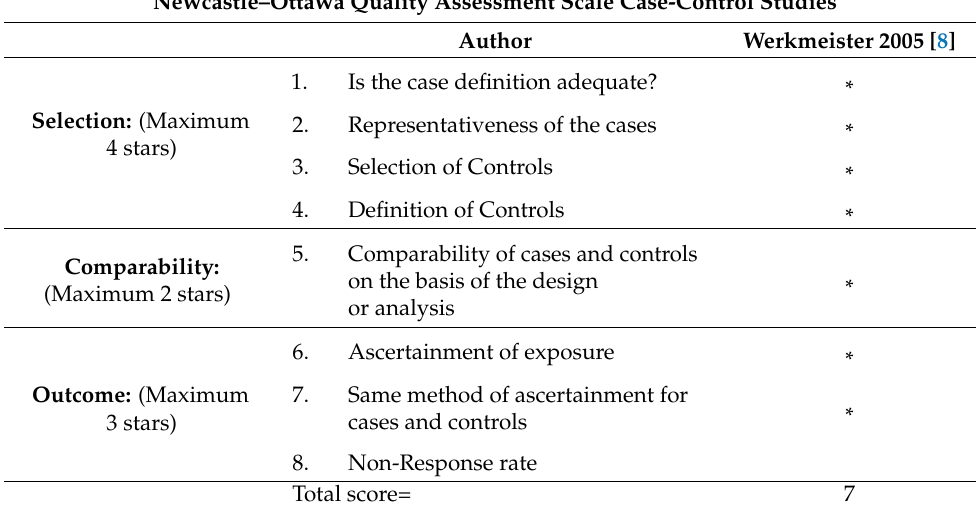
Table 3. Newcastle–Ottawa quality assessment scale for case-control